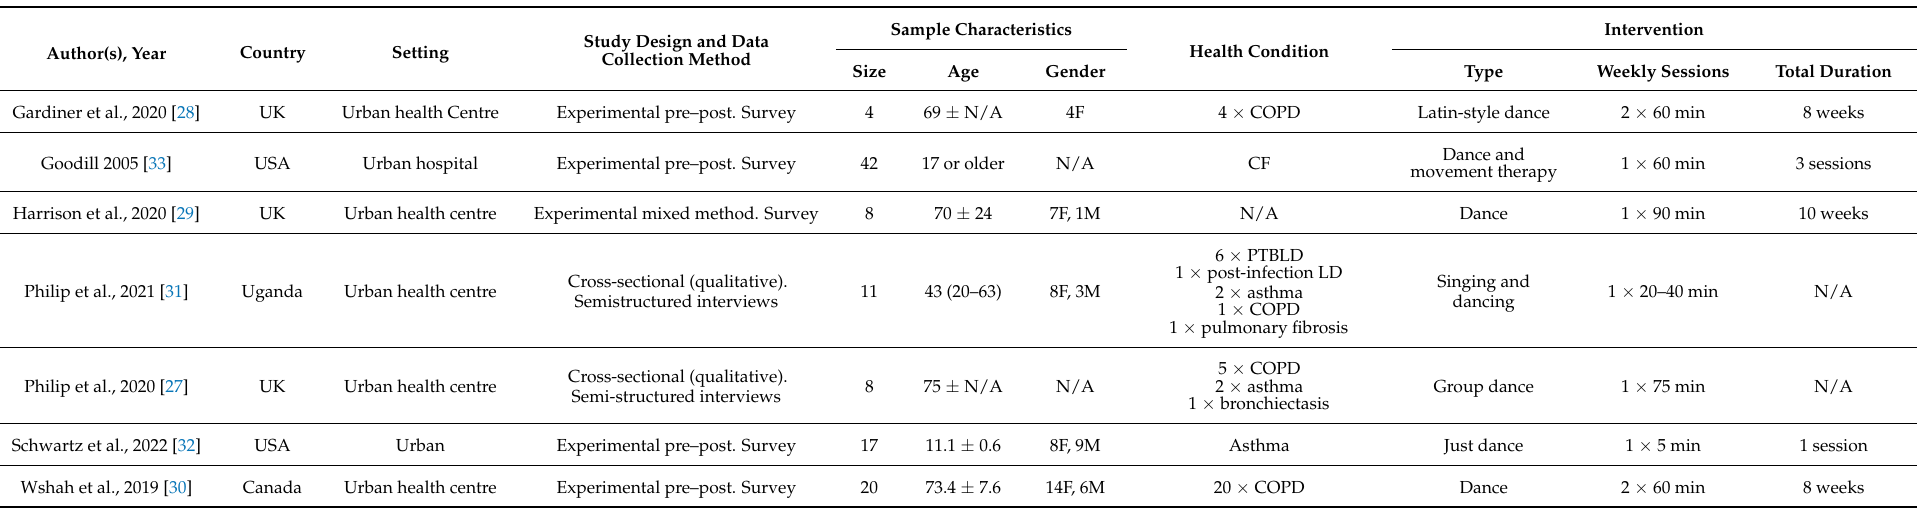
Table 1. Summary of studies included in this systematic